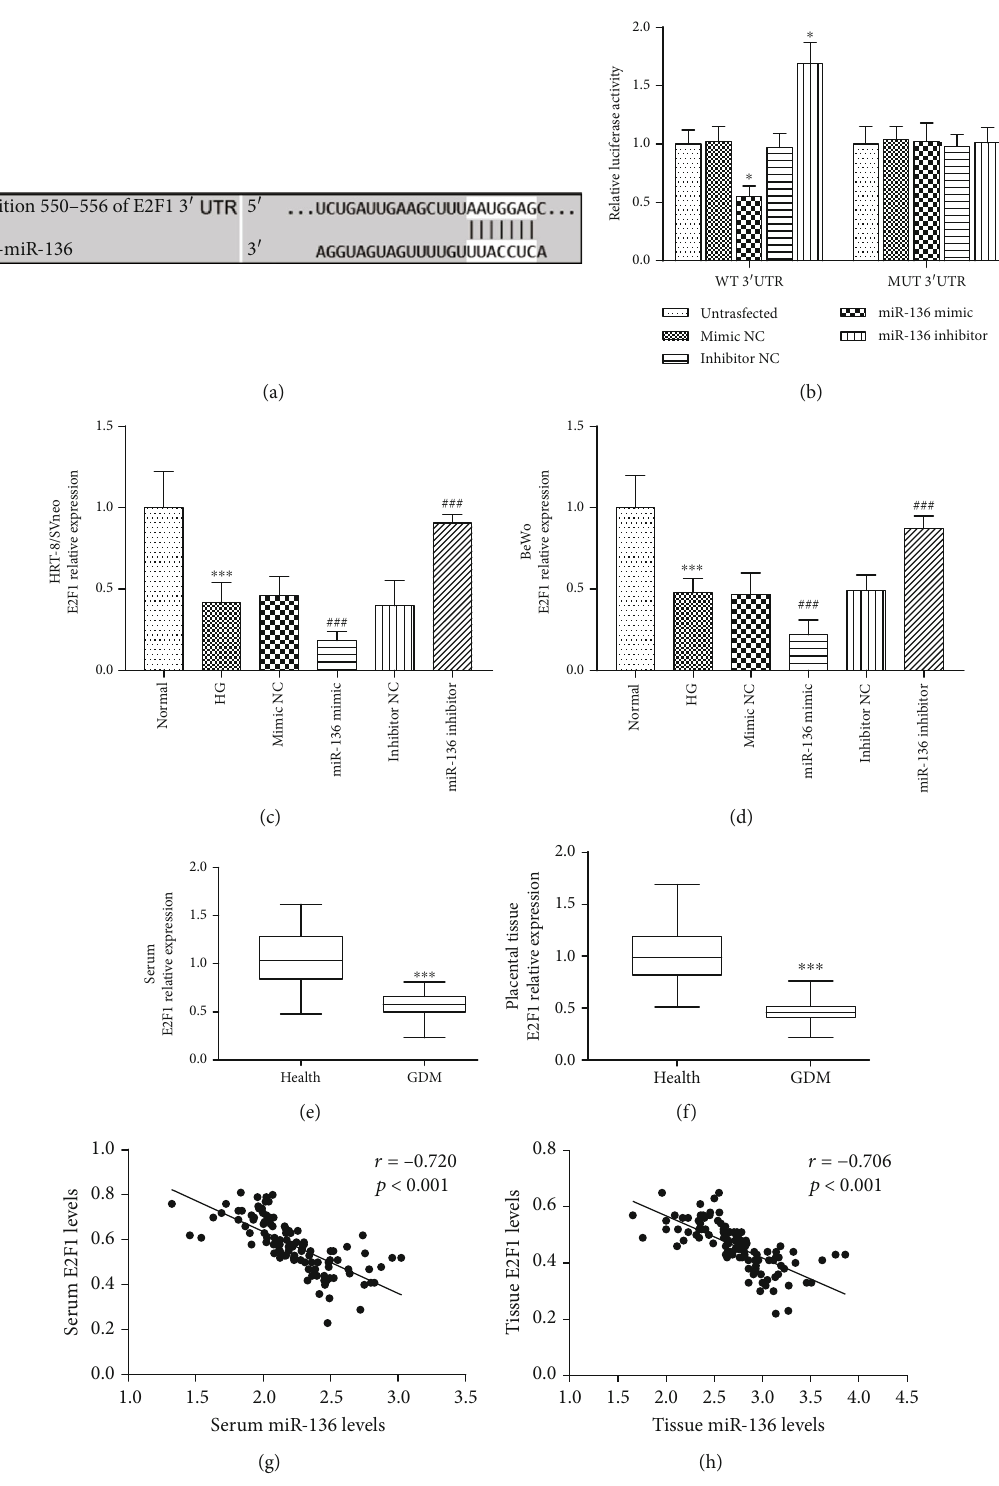
Figure 4: miR-136 directly regulates E2F1 in trophoblast cells and their negative correlation. (a) The putative binding site of miR-136 at the 3 ′ -UTR of E2F1. (b) The relative luciferase activity was inhibited by the overexpression but enhanced by the knockdown of miR-136 in wild- type (WT) 3 ′ UTR group ( ∗ P < 0 : 05 ). (c, d) The expression of E2F1 was inhibited by high glucose, and this e ff ect was strengthened by miR-136 overexpression, but was weakened by the silencing of miR-136 in both HRT-8/SVneo and BeWo cells ( ∗∗∗ P < 0 : 001 vs. normal; ### P < 0 : 001 vs. HG). (e, f) The expression of E2F1 in serum and placental tissues was decreased in GDM patients compared with healthy controls ( ∗∗∗ P < 0 : 001 ). (g, h) The levels of miR-136 were negatively correlated with E2F1 levels in GDM patients. HG: high